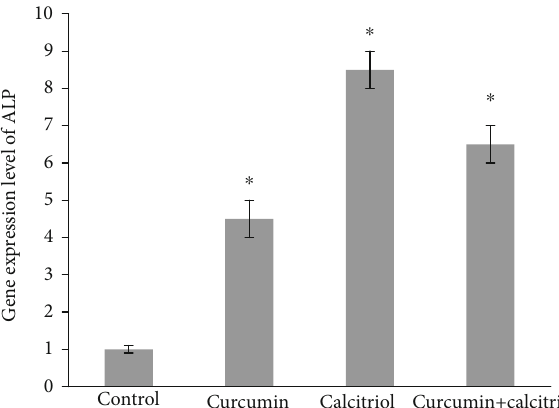
Figure 3: ALP gene expression on DPSCs treated with the combination of curcumin and calcitriol in 7